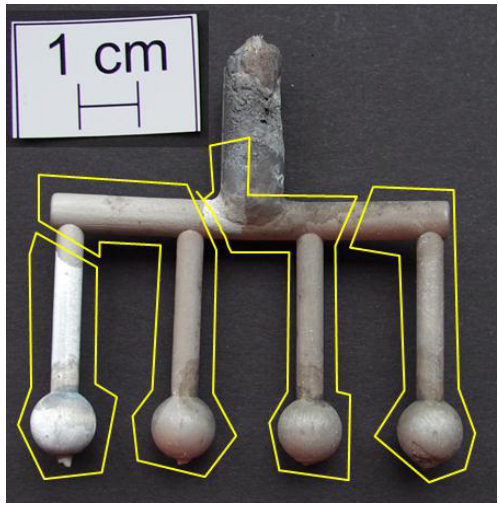
Figure 5. Macroetched sample of Alloy1. The grain structure is denoted by